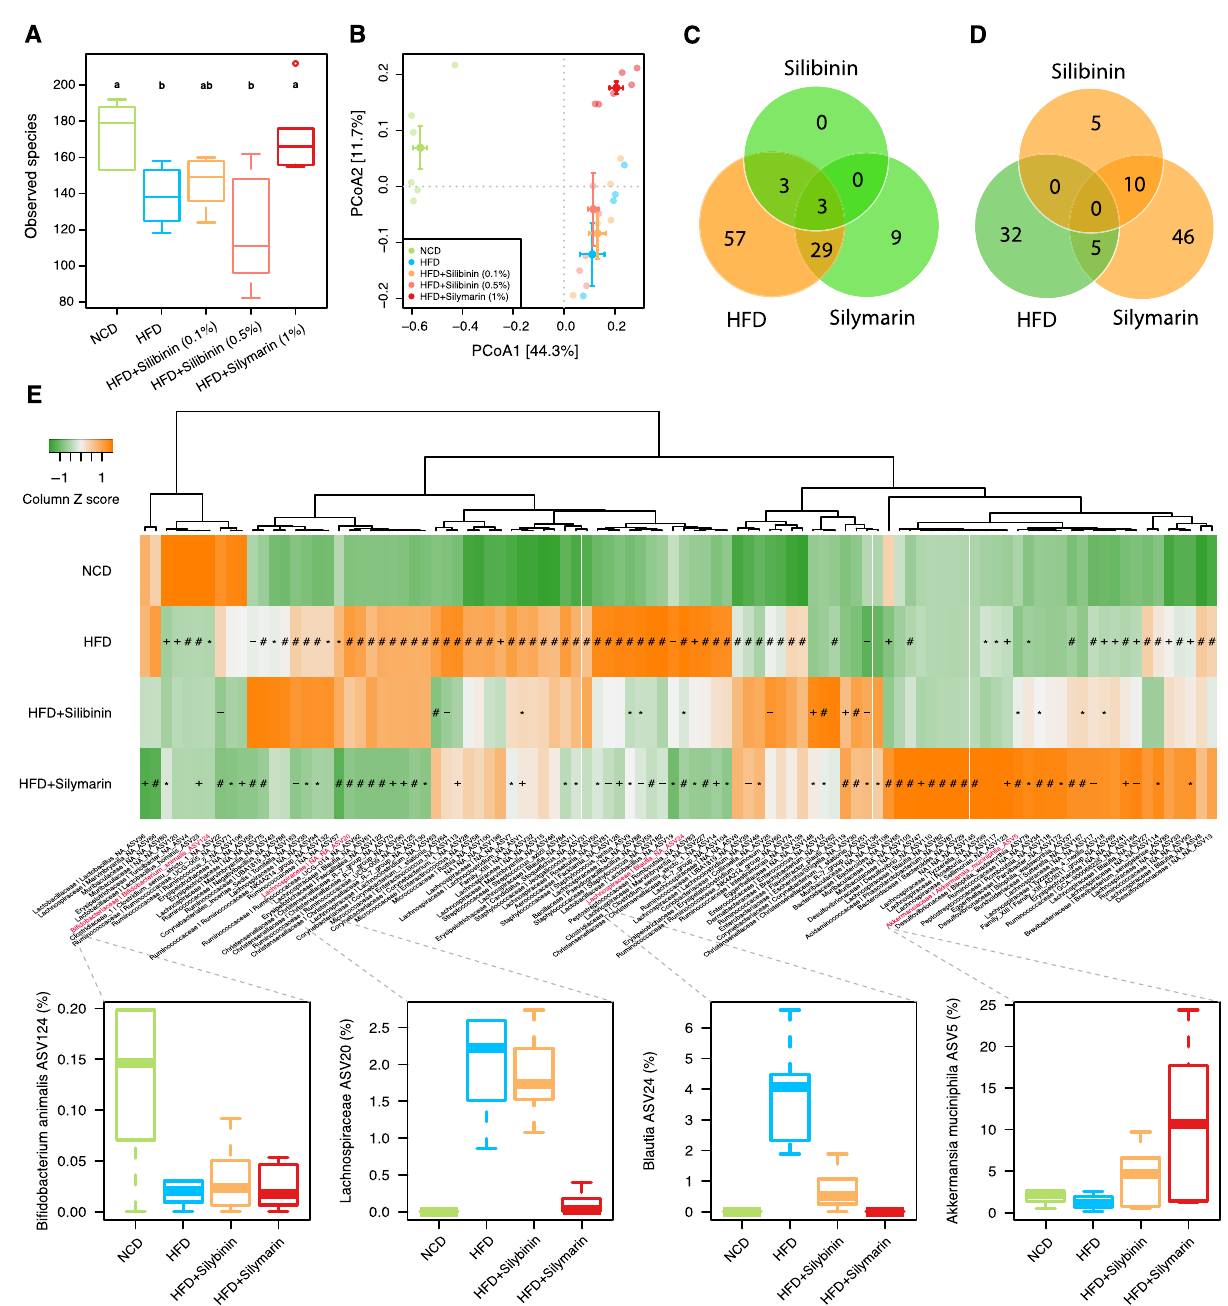
Fig. 2 | Microbial compositional changes in different treatment groups. Box- plots showing the alpha diversity measured by observed species ( A ) and the prin- cipal coordinate analysis ( B ) of the gut microbiota. C , D Venn plots showing the numbers of signi fi cantly increased (colored in yellow) and decreased (in green) ampliconsequencevariations(ASVs)inHFDvs.NCDandsilymarin/silibininvs.HFD groups; the two silibinin groups were combined for this analysis. E Heatmap showing the mean relative abundances of the top 100 ASVs in different groups; changes in the relative abundances of four representative ASVs were further